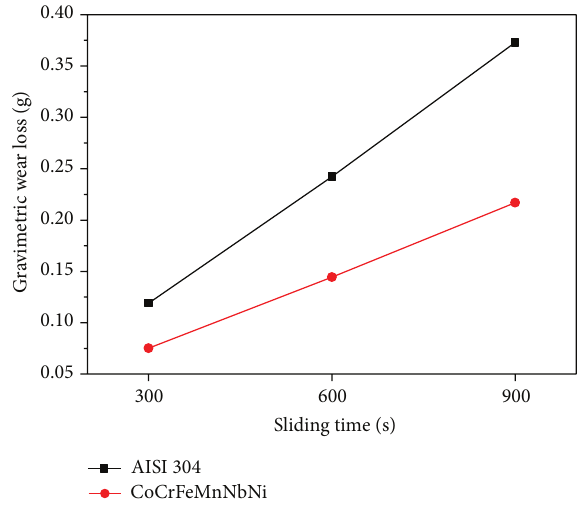
Figure 5: Mass losses of CoCrFeMnNbNi HEA coating and sub- strate as a function of sliding